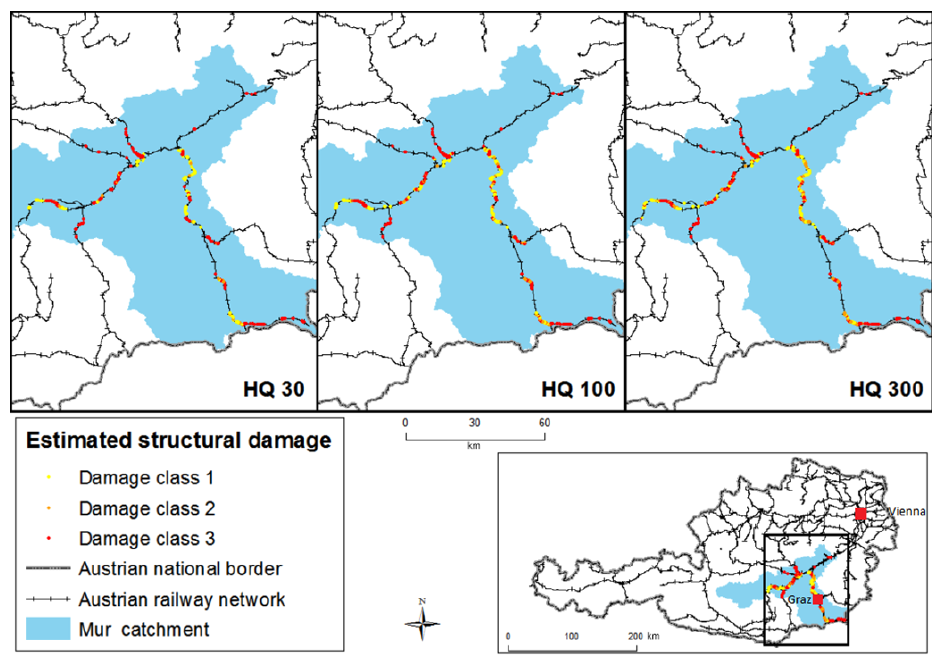
Figure 3. Estimation of damage potentials. The map shows the RAIL model results for synthetic flood events of return periods of 30 years (left), 100 years (middle) and 300 years